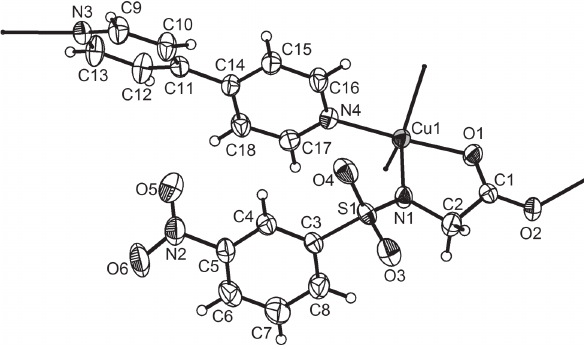
Table 1: Data collection and